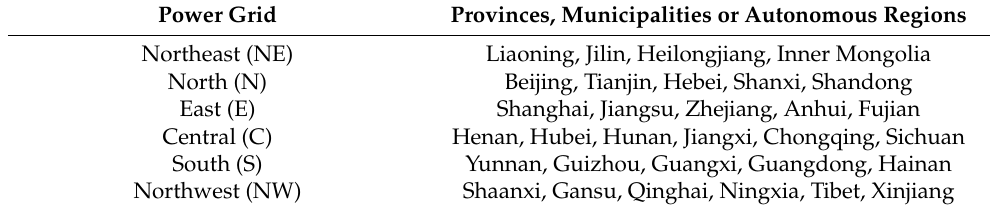
Table A1. Regional division.